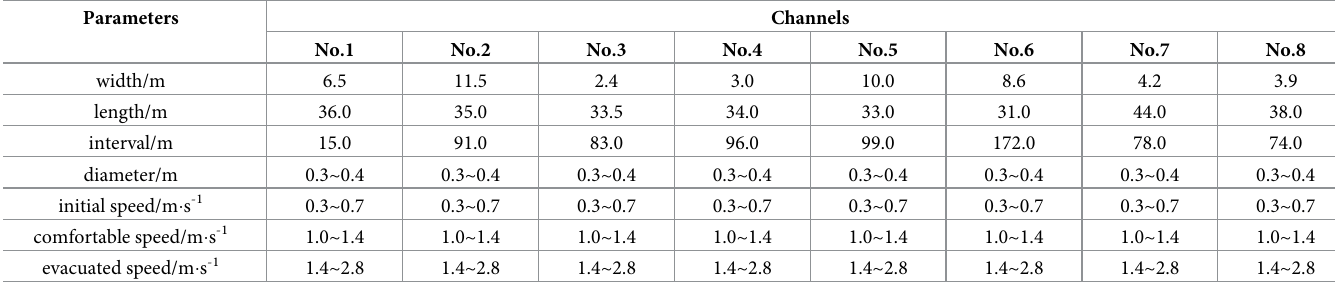
Table 4. Result of measurable parameters for